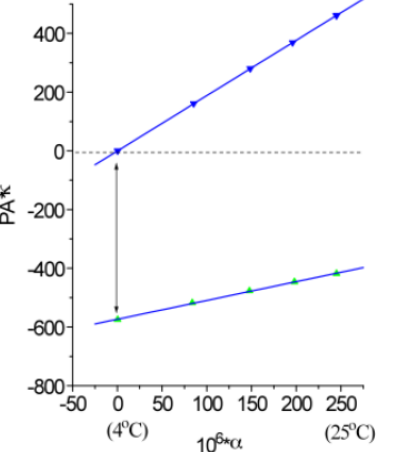
Figure 2. Typical plot of the product of the photoacoustic signal and water compressibility (  ) versus water expansivity (  ) for ink reference (blue symbols) and PS I complex (green